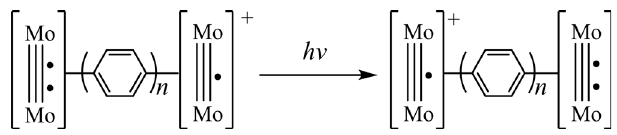
Fig. 3 Schematic description of donor-acceptor electron transfer in the phenylene bridged Mo 2 dimer. In the singly oxidized mixed-valence complex, the quadruply bonded [Mo 2 ] unit serves as the electron donor and the cationic [Mo 2 ] unit having a Mo – Mo bond order of 3.5 is the electron acceptor. Electron transfer causes δ bond breakage on the donor and formation on the acceptor, but the other bonds ( σ and π ) remain